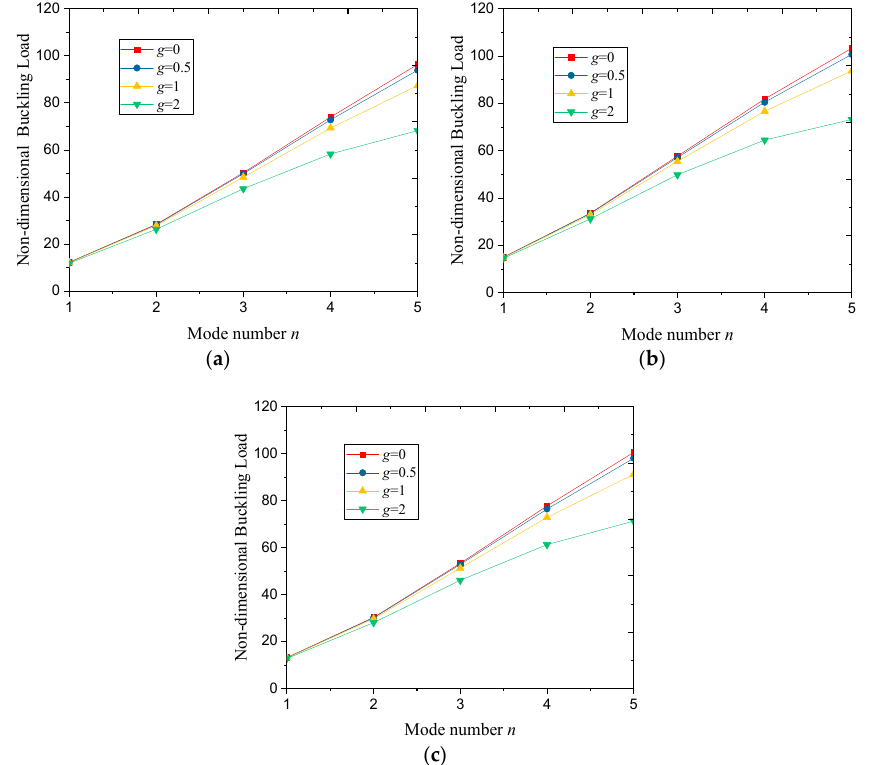
Figure 4. Variation of the non-dimensional buckling load with a mode number n of square FG nanoporous nanoplate ( m = 1, h = 5 nm, ζ = 1, l a = l b = 50 nm, λ = 0.5): ( a ) UD, ( b ) NUD1, ( c ) NUD2.